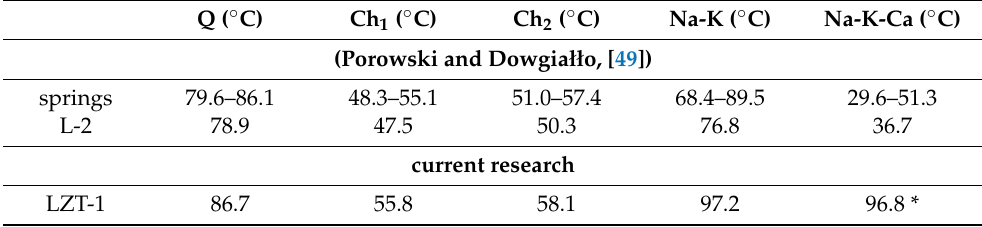
Table 4. Estimated deposit temperature of water ( ◦ C) from LZT-1 intake against deposit temperatures of waters from the L ˛adek-Zdr ó j intakes (min.–max. temperature ranges are given for